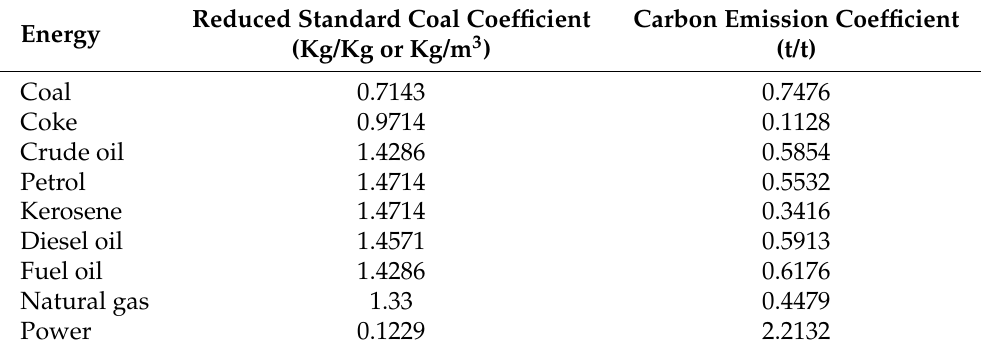
Table 1. Reference coefficient and carbon emission coefficient of standard coal converted from various energy